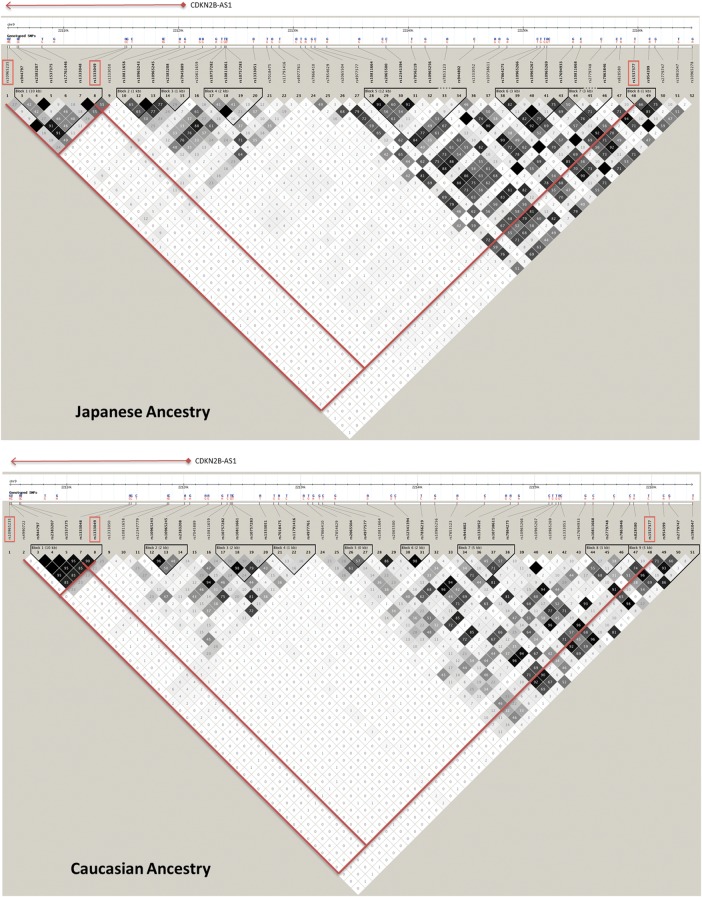
Linkage disequilibrium structure for the region containing rs1537377, rs1333049 and rs10965235 in/near CDKN2BAS on chromosome 9 in individuals of European ancestry (bottom panel) and of Japanese ancestry (top panel) (Source:
http://hapmap.ncbi.nlm.nih.gov).